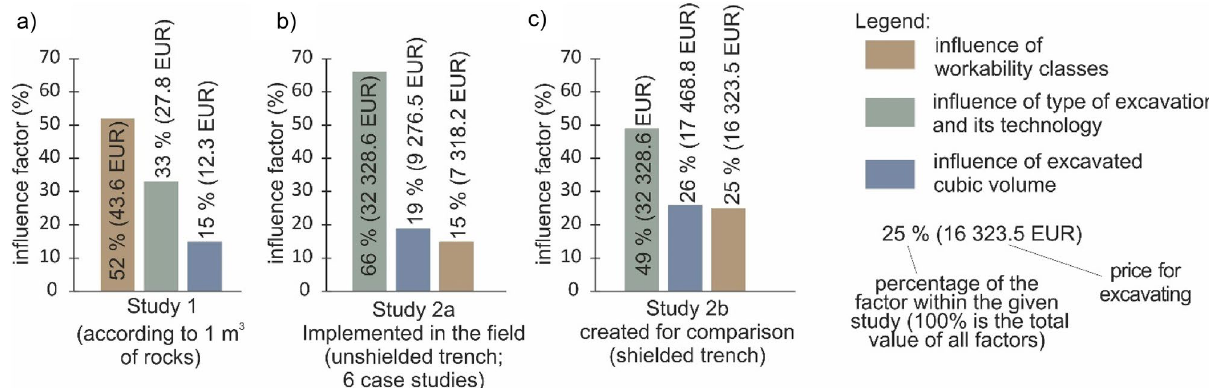
Figure 12. Graph of study results with quantified levels of influence of the different factors on the price of earthwork (workability class, type of excavation and its technology, excavated cubic volume), ( a ) study 1; ( b ) study 2a; ( c ) study